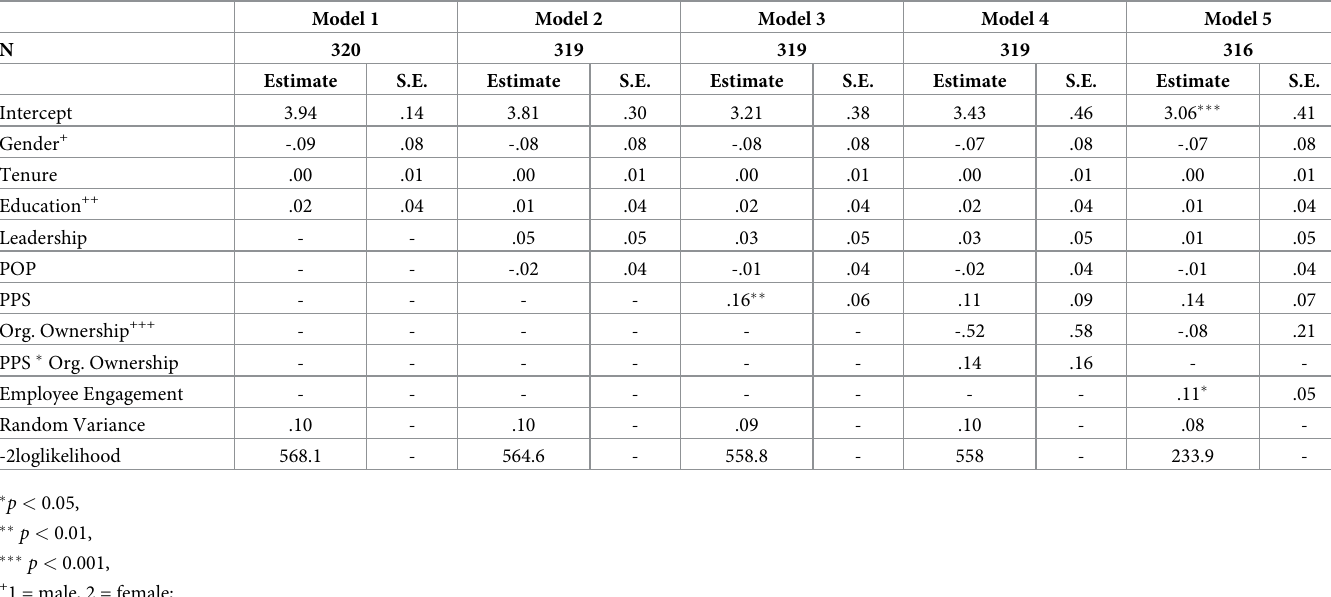
Table 5. Multi-level analysis with OCB as dependent variable.